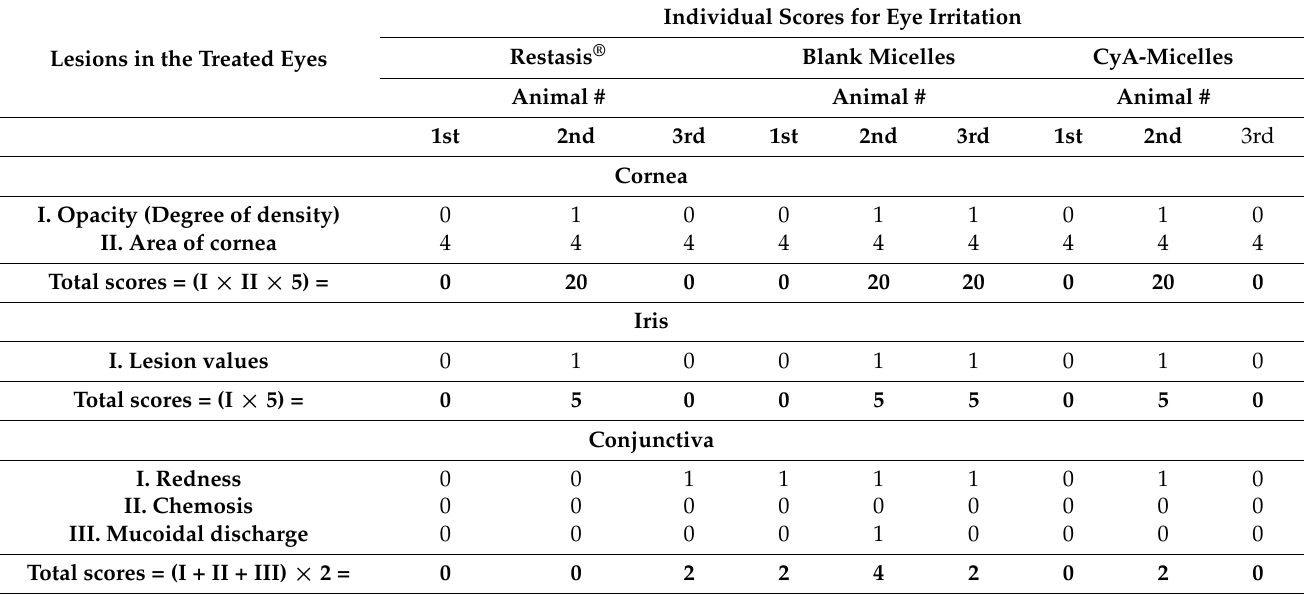
Table 4. Weighted scores for eye irritation test by Restasis ® , blank micelles, and CyA-Micelles.